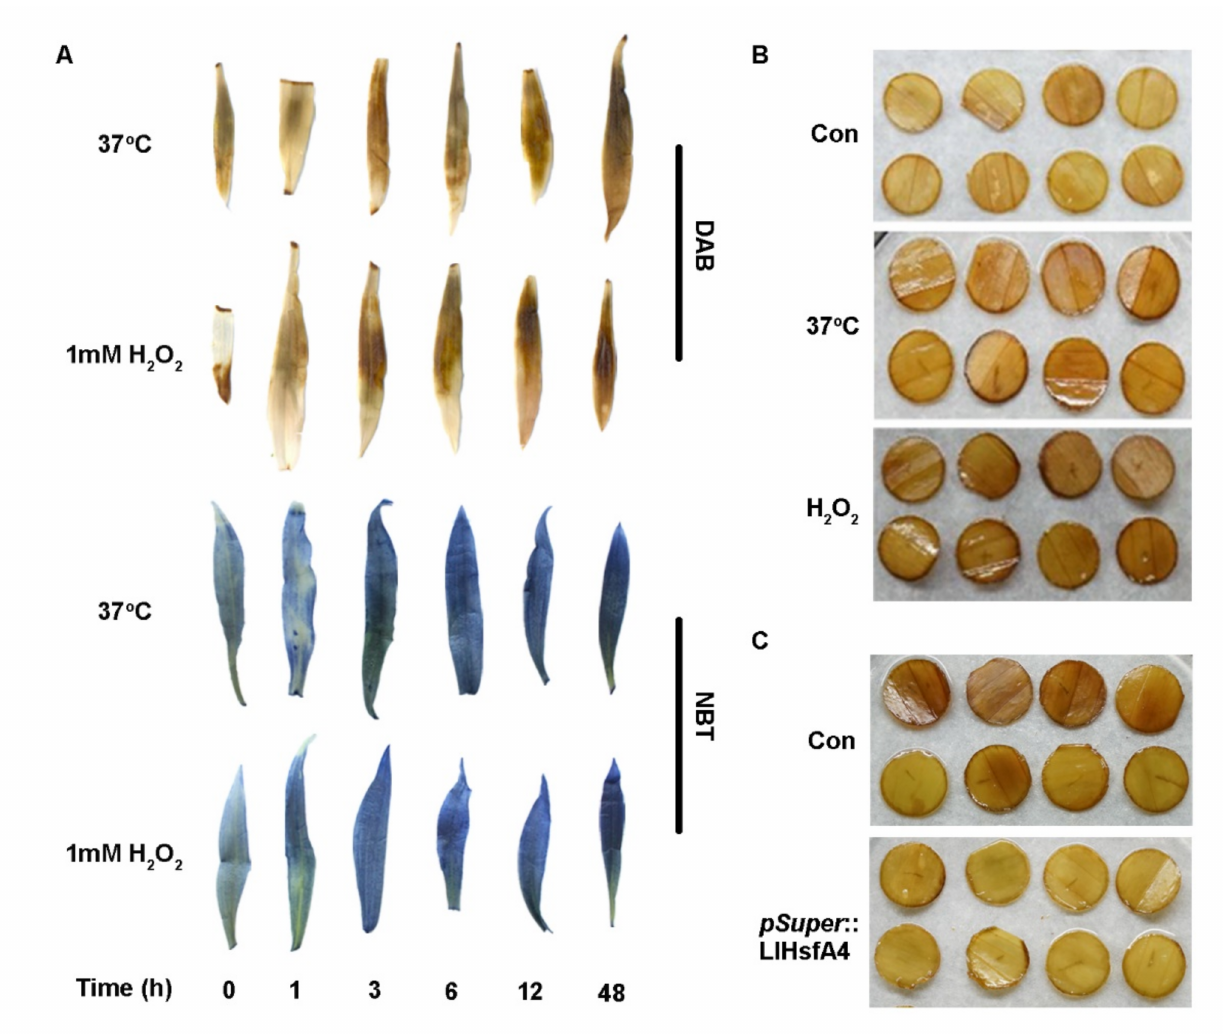
Figure 8. Content of ROS detected in lilies. ( A ) Leaves of ‘White Heaven’ tissue culture seedlings were stained by DAB staining or NBT staining under heat (37 ◦ C) and H 2 O 2 treatment. ( B ) Discs from mature leaves of cut flowers ‘Siberia’ were stained by DAB staining under heat (37 ◦ C) and H 2 O 2 treatment. ( C ) Discs from mature leaves of cut flowers ‘Siberia’ were stained by DAB staining under transient expression with LlHs fA4 under heat (37 ◦ C)